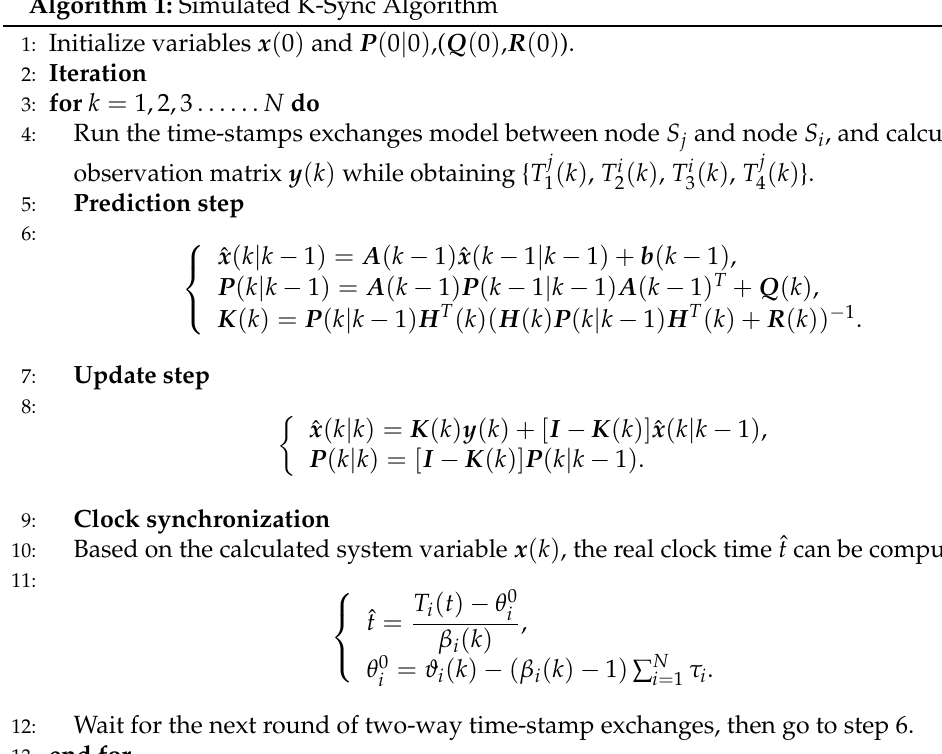
Algorithm 1: Simulated K-Sync